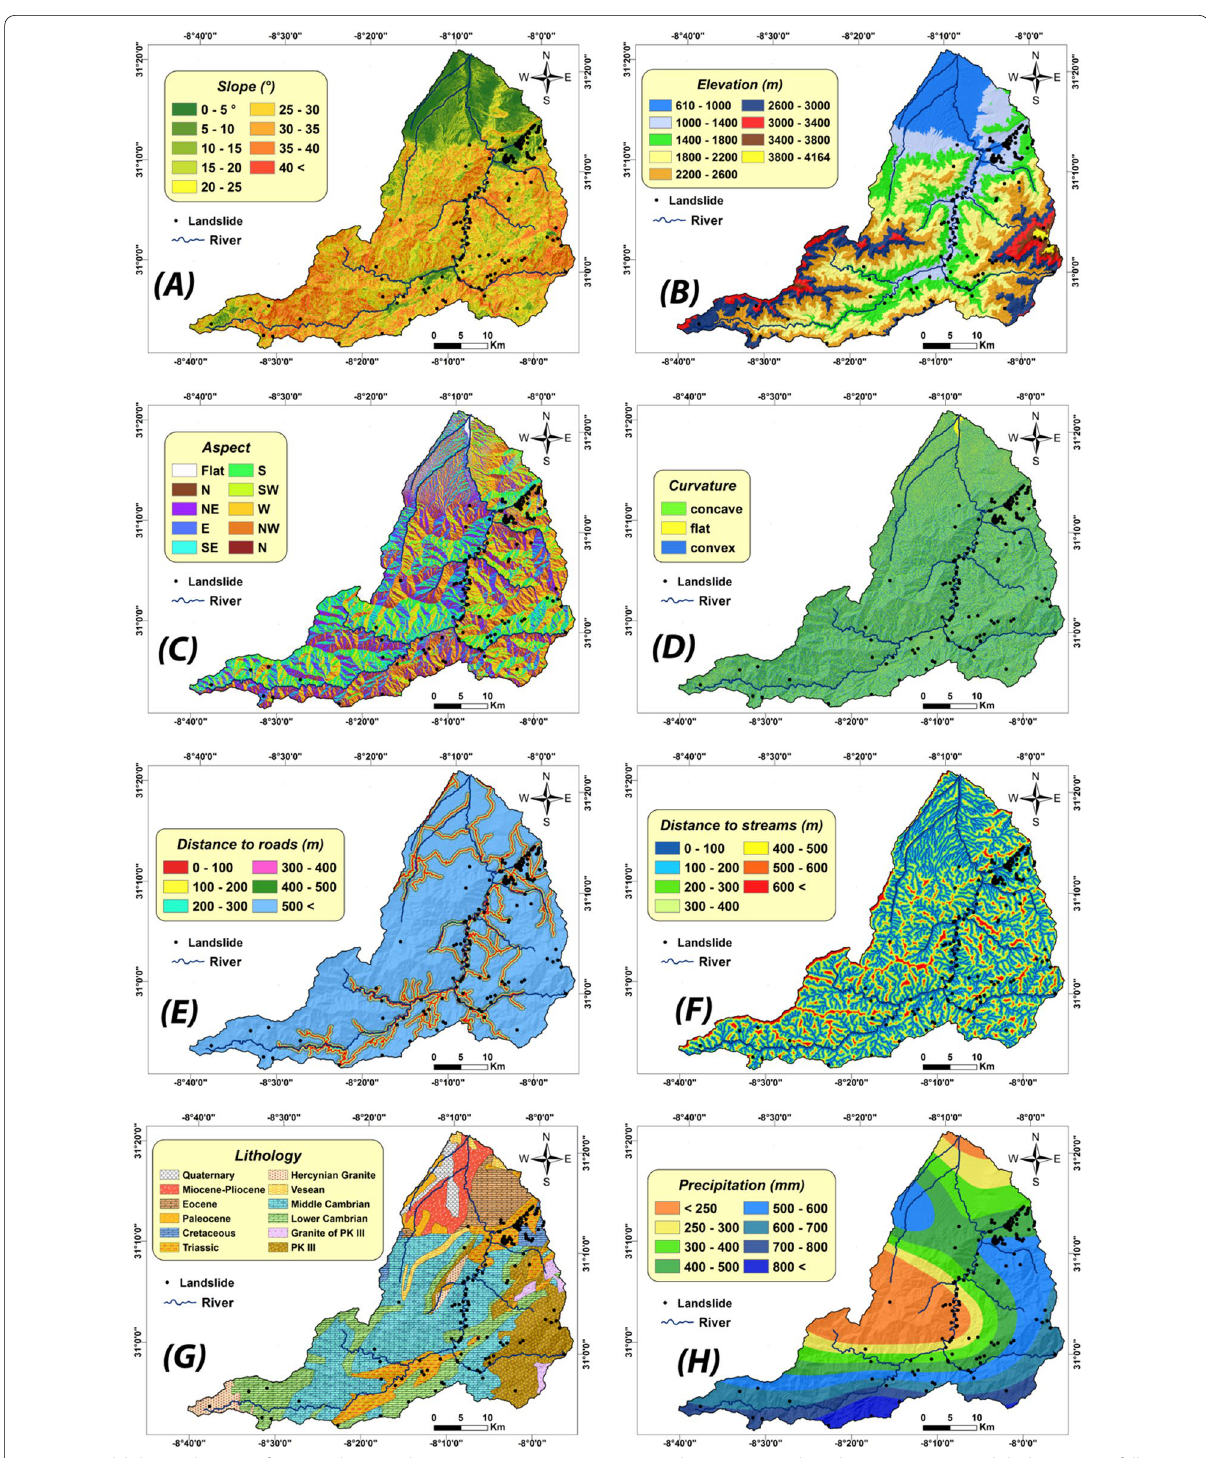
Fig. 4 Landslide conditioning factor A slope, B elevation, C aspect, D curvature, E distance to roads, F distance to rivers, G lithology, H rainfall, I NDVI, J land use, K distance to faults L TWI, M soil type, N